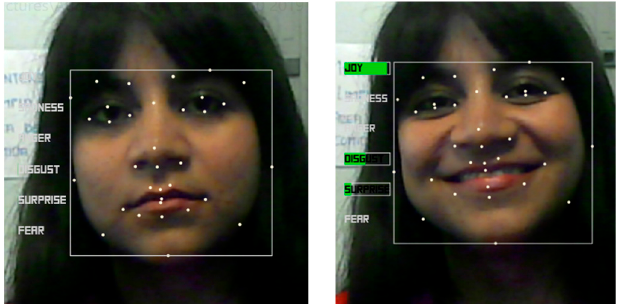
Figure 5. The orientation of the reference points for the detection of moods. The displacement of these points is computed to identify expressions. Figure 6 illustrates the mean classification rates and the observed standard deviation values obtained by applying S-ELM formulation. Note that for some of the databases, the individual performance was lower; however, the detector implemented was trained with the general integration of the databases. This means that in very noisy scenarios, we have recognition rates of 68% and for controlled scenarios up to 96% in the recognition rate, but it is regularly stable at 88%.